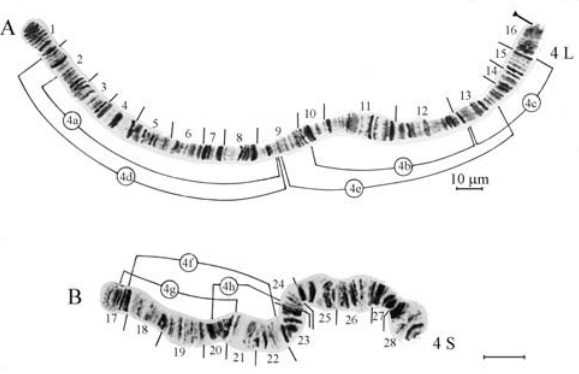
Figure 4 - Photomicrographic map of Drosophila annulimana chromo- some 4. A: long arm (4L) with the breakpoints of inversions 4a/+, 4b/+, 4c/+,4d/+and4e/+indicated;B:shortarm(4S)withthebreakpointsofin- versions 4f/+, 4g/+ e 4h/+ indicated. Scale bars = 10 μ m.